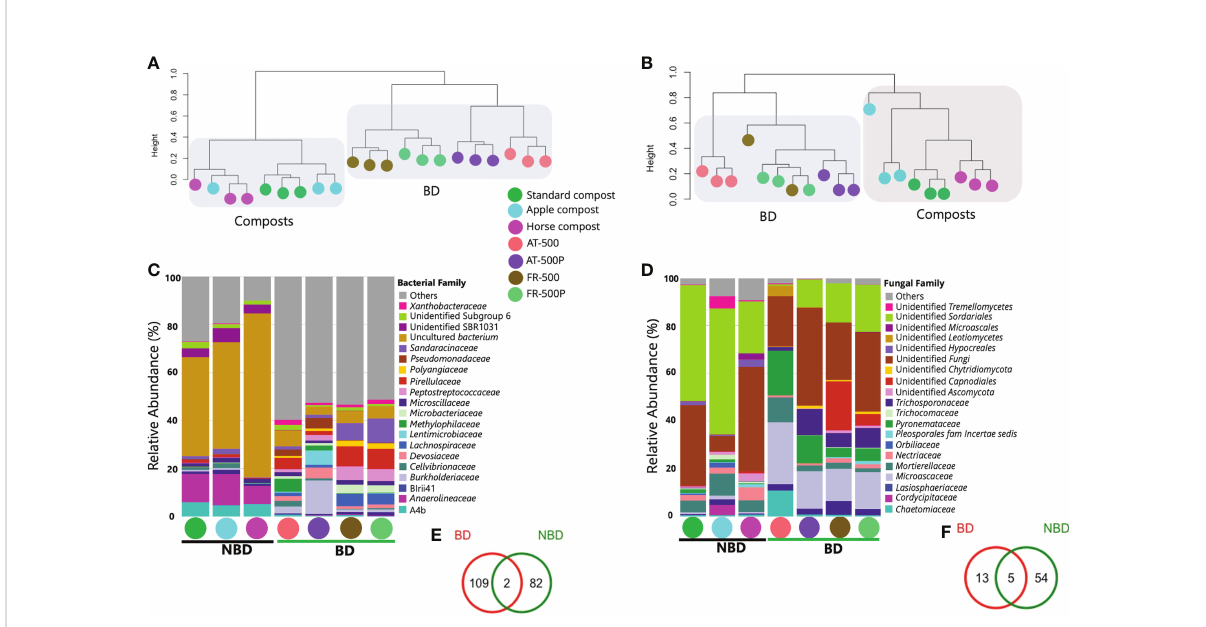
FIGURE 1 Microbial community structure and composition of BD manures and composts. Coloured circles represent the different BD manures (500/P) and non-biodynamic (NBD) composts. Figures (A, B) are dendrogram representation of the bacterial and fungal community obtained by complete clustering of the Bray Curtis distance matrix. (C, D) are stacked bar plots showing the bacterial, and fungal taxonomic composition in the different BD and compost samples; while (E, F) represent shared and unique ASVs between BD manures and composts for bacterial and fungal communities, respectively. The common microbiome was de fi ned as ASVs with prevalence >50% and relative abundance >0.001%. AT and FR indicate countries Austria and France,